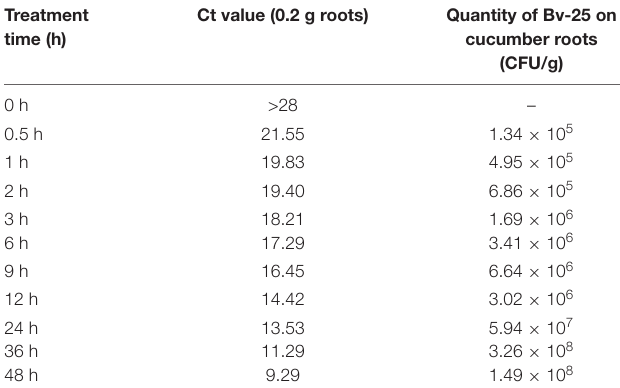
TABLE 1 | Quantification of strain Bv-25 on cucumber roots by quantitative PCR. Treatment Ct value (0.2 g roots) Quantity of Bv-25 on time (h)